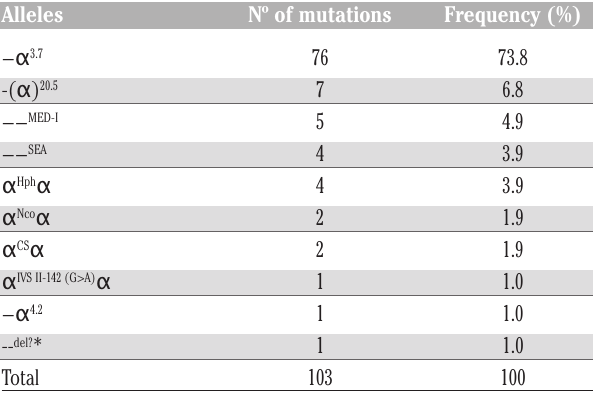
Table 1. Spectrum of α -gene defects. Alleles Nº of mutations